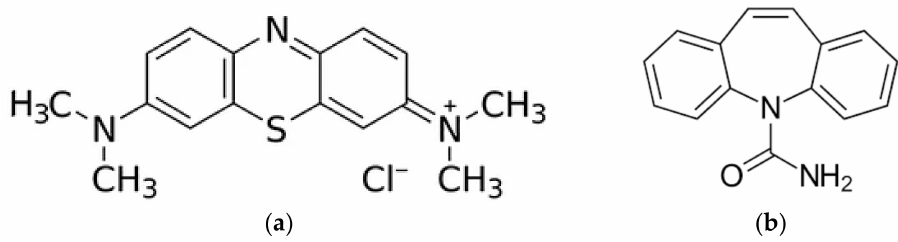
Figure 3. The chemical structure of ( a ) methylene blue chloride salt and ( b )